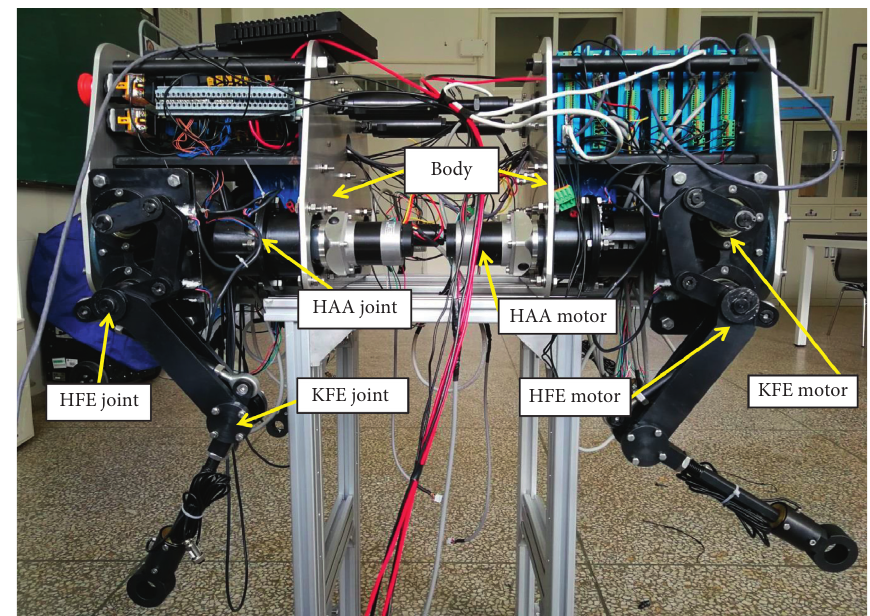
Figure 1: Experimental prototype of MQ quadruped robot.